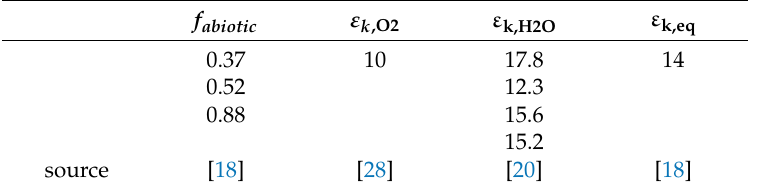
Table 1. Values compiled from several sources to model kinetic isotope effects and abiotic exchange on the oxygen isotopic composition of NO 3 − during nitrification. The colored values for f abiotic correspond to the colored line in Figure 6. Here, we used an average of the values shown for ε k,H20